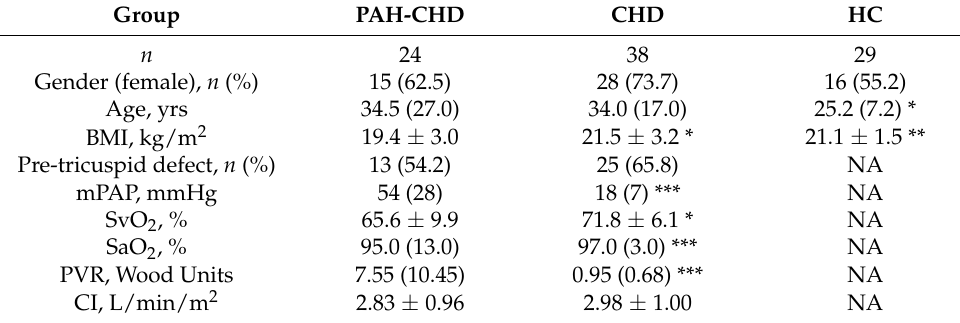
Table 1. Demographic and clinical characteristics of grouped